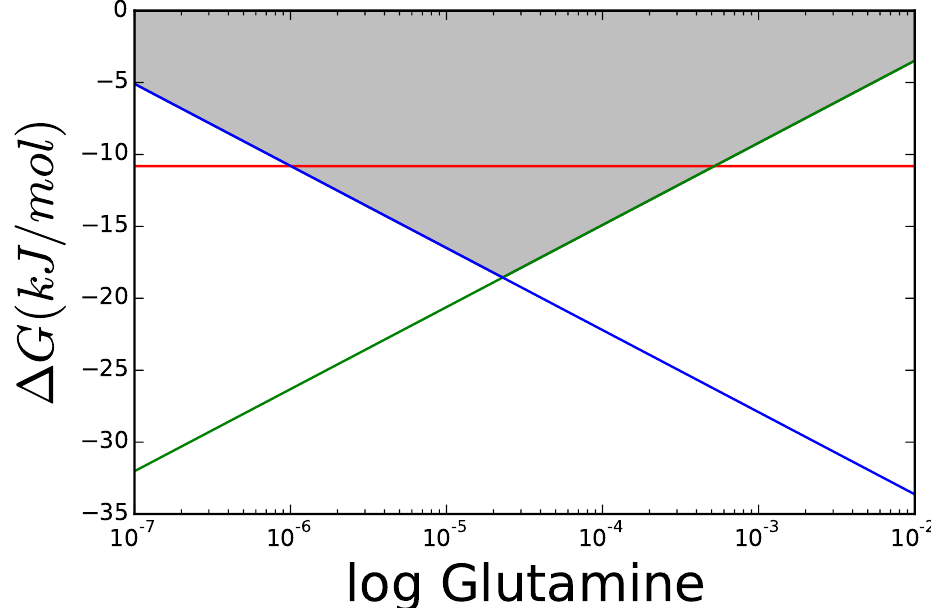
Figure 8. The lines represent the ∆ G of each reaction at different concentrations of glutamine for a fixed NH = 1 mM. Concentrations of other metabolites taken from the 3 literature (see supplementary information), except α -ketoglutaric acid that was set as high as the default boundary permitted. Red GDH, green GS and blue